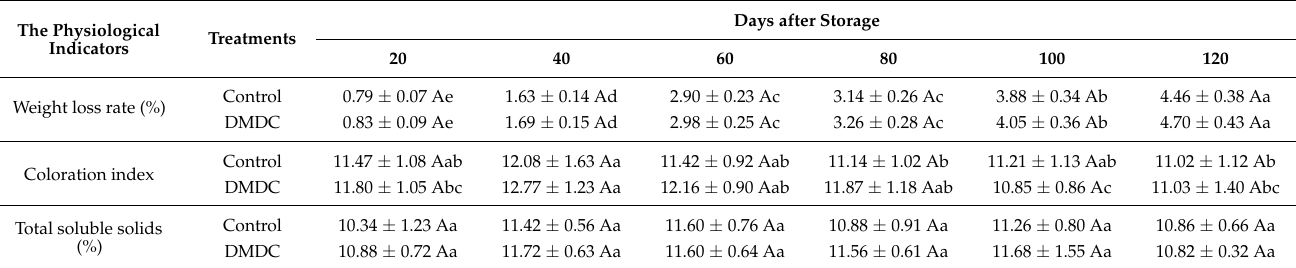
Table 1. Results of fruit quality determination after DMDC treatment.